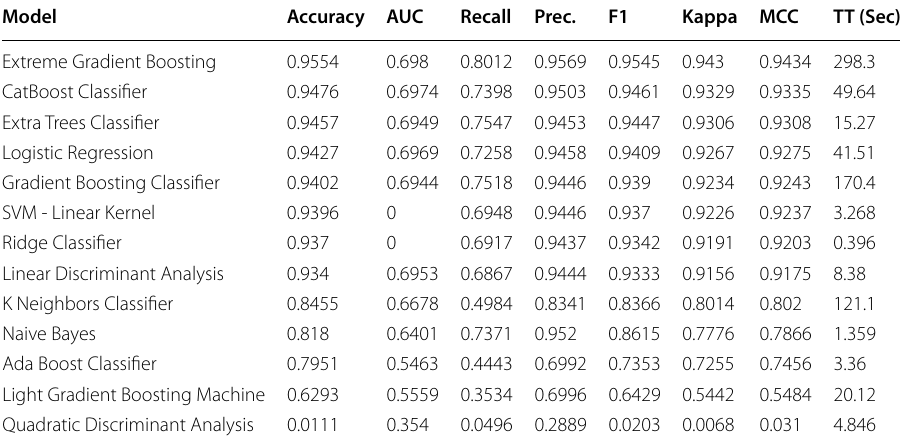
Table 5 Comparison of various classification models for transaction categorization task